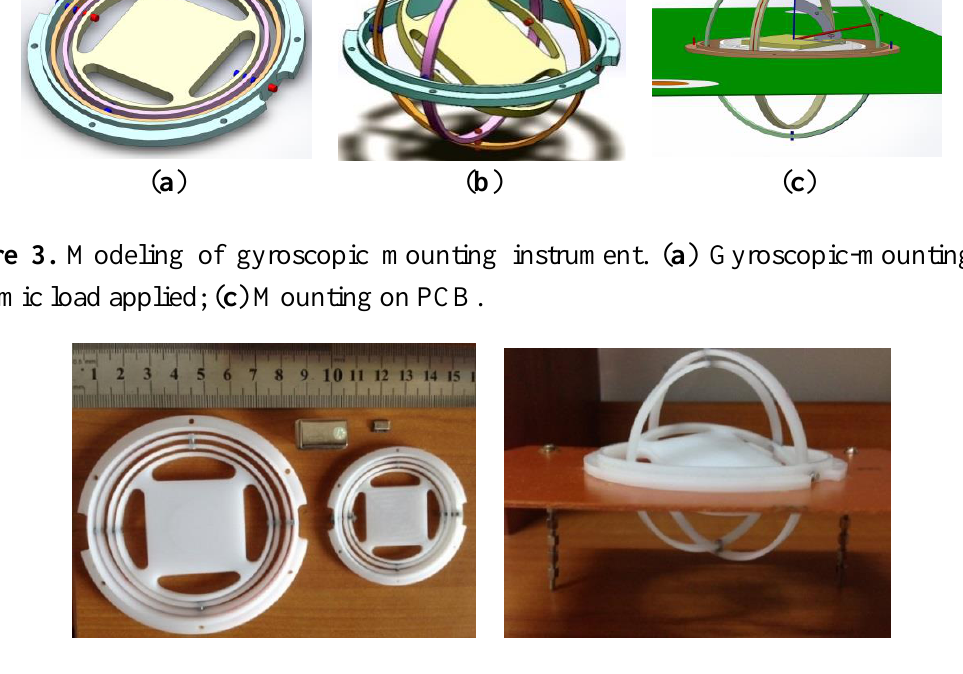
Figure 4. Prototype of gyroscopic mounting